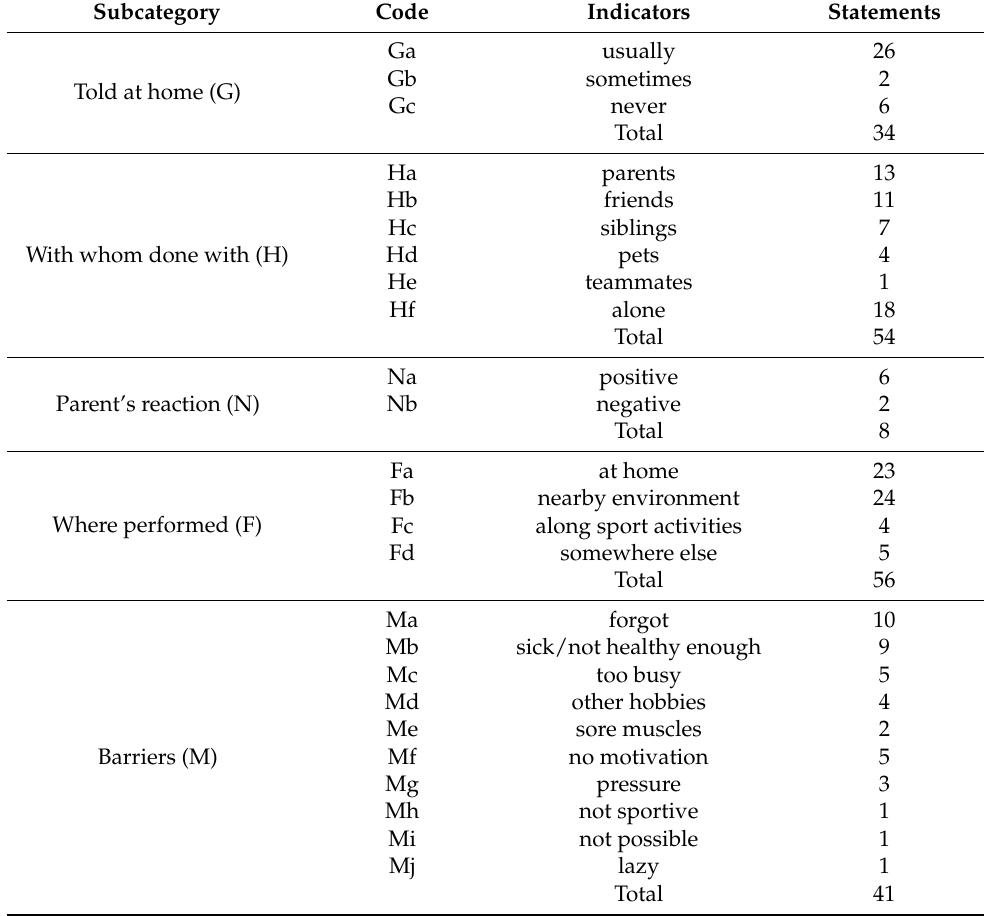
Table 1. The analysis summary of students’ interviews (N =